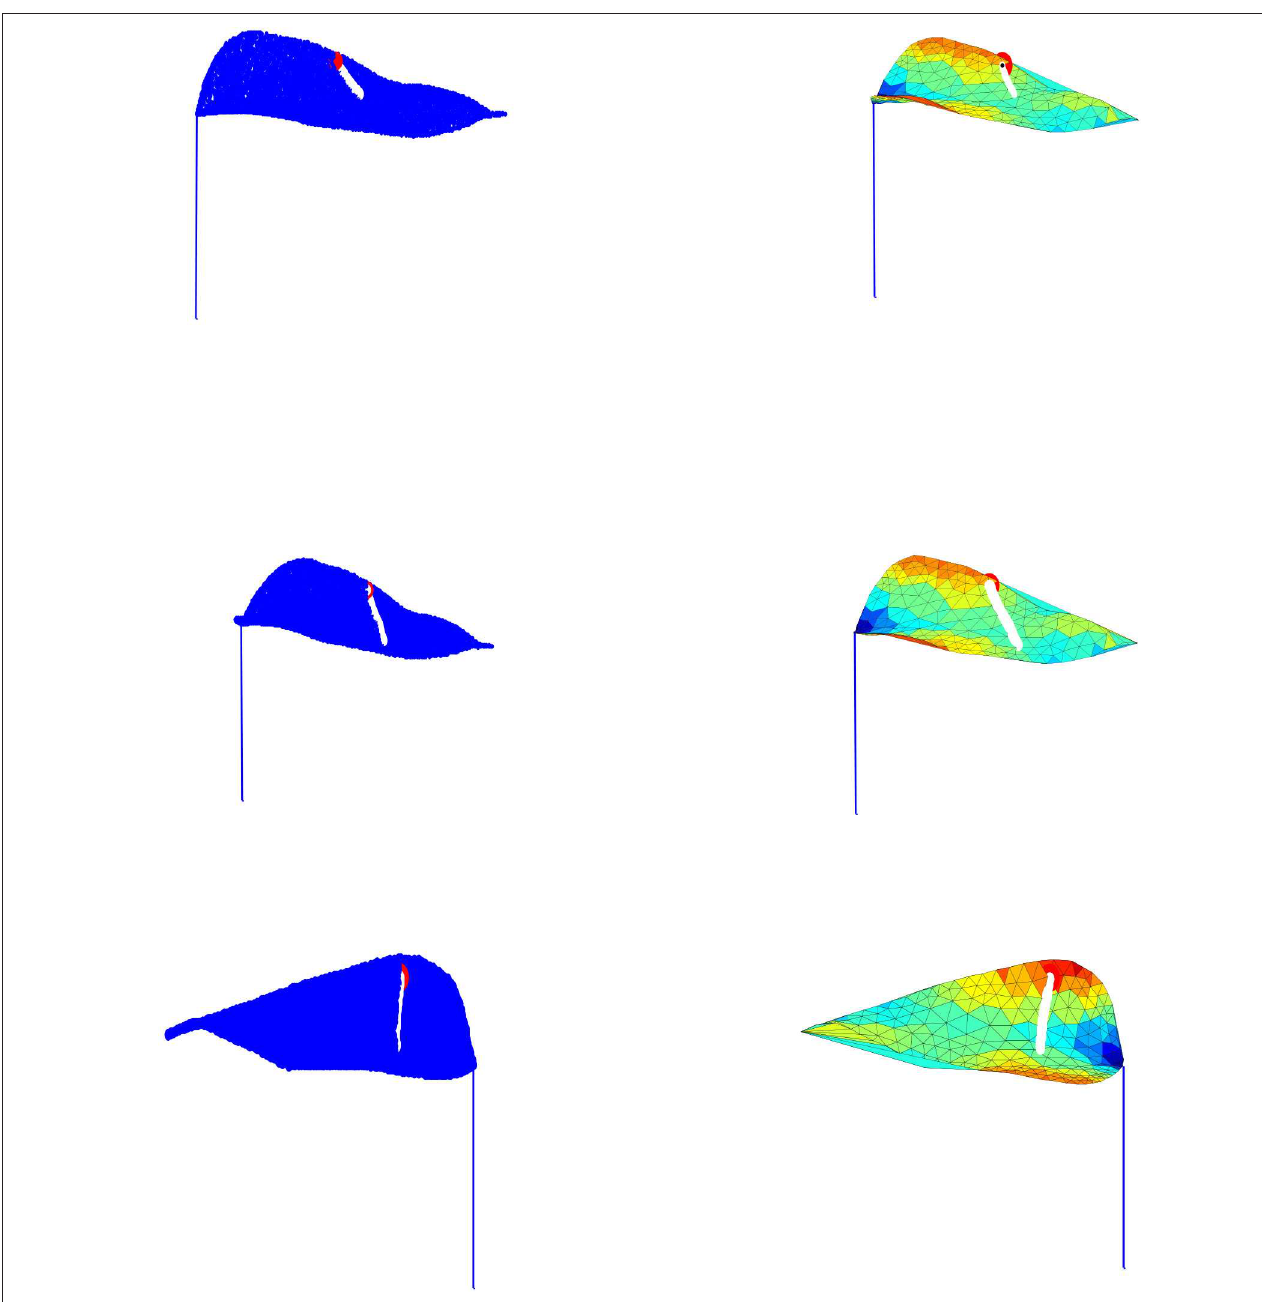
FIGURE 7 | The figures given on the left column represent the droplet motion by implementing the stopping tolerance in our model across the constructed leaf, while the figures given on the right column show the corresponding droplet movement on the leaf triangulation.